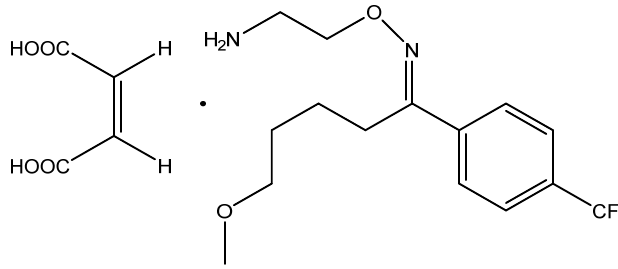
Figure 1. of fluvoxamine maleate. Figure 1. Of fluvoxamine